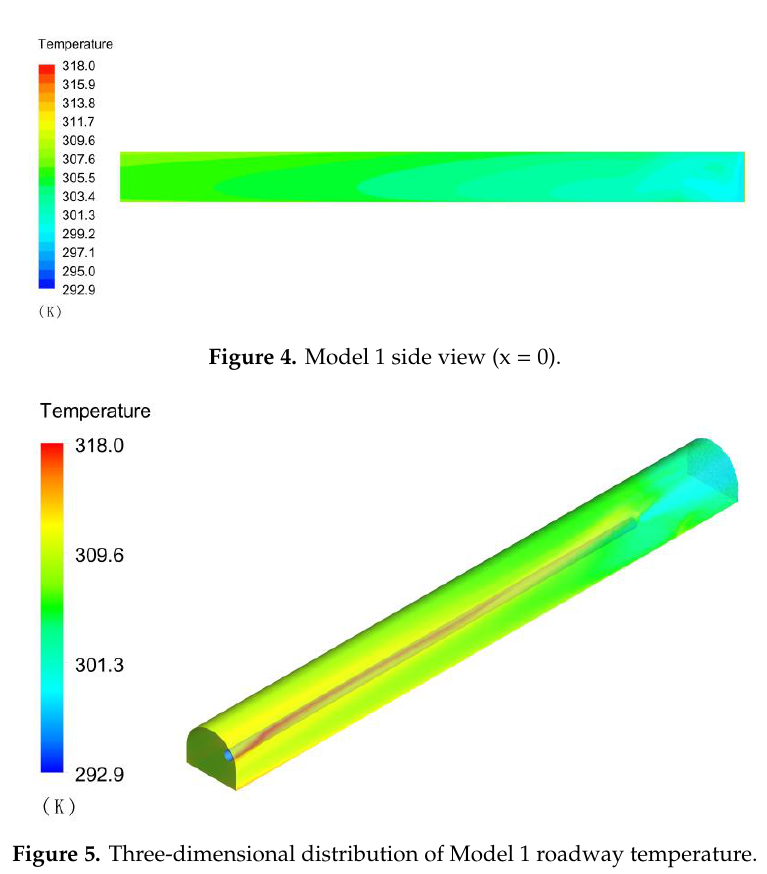
Figure 3. Model 1 section temperature distribution.